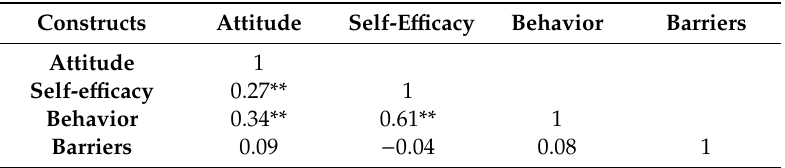
Table 7. Bivariate